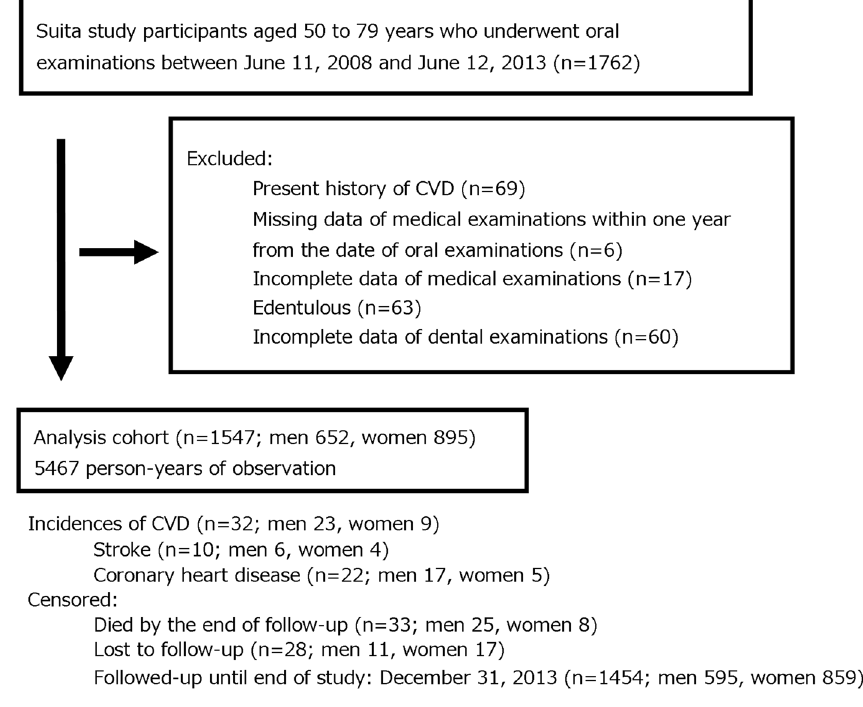
Figure 1. Flow chart of study participants. CVD, cardiovascular